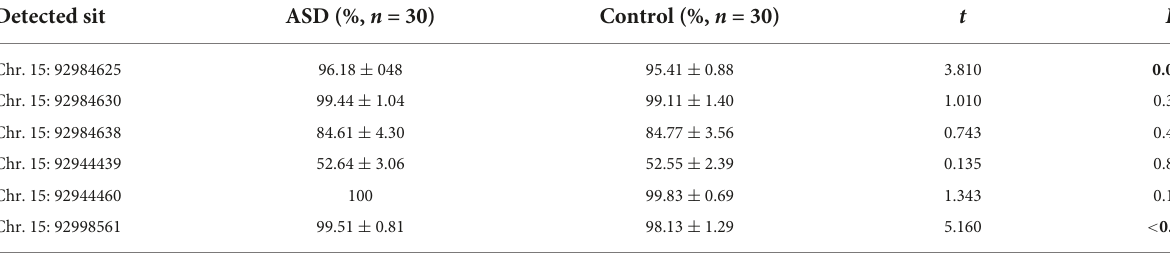
TABLE 3 Methylation level of ASD and controls at the detected site in ST8SIA2 (mean ± SD). Detected sit ASD (%, n =